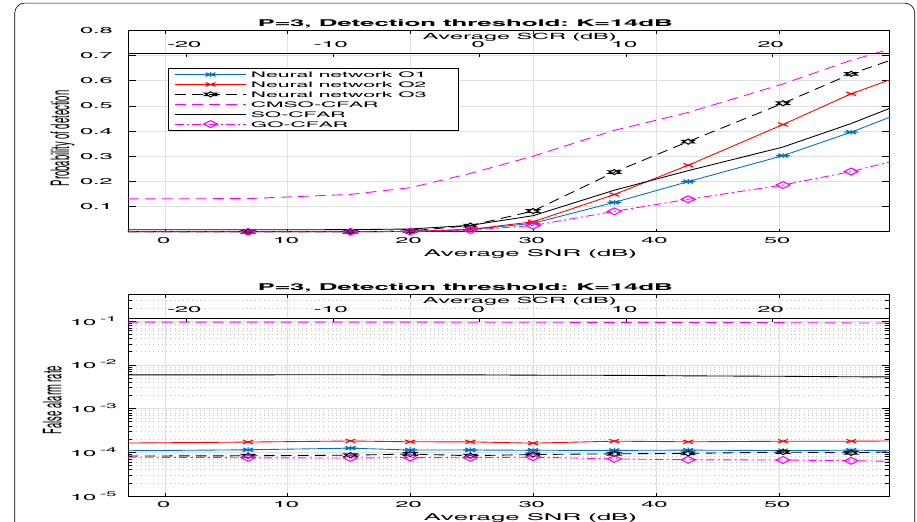
Fig. 9 P D and P FA , Clutter and noise scenario, 50 x 2 network, P =